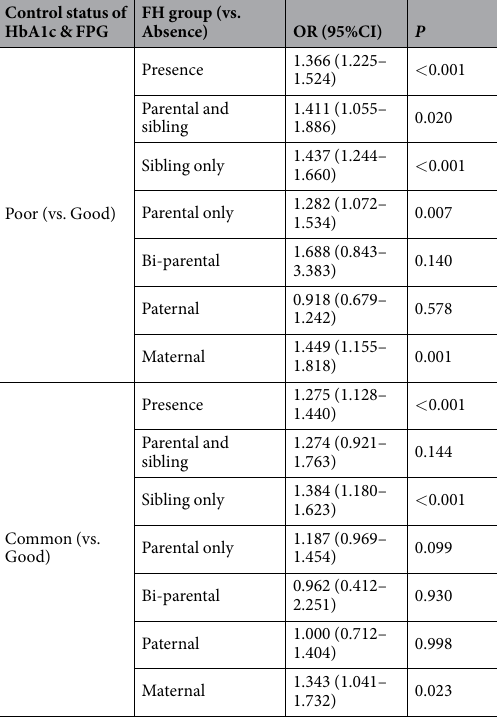
Table 3. Multiple logistic regression analysis of FH of diabetes and glycaemic control. Adjusted for age, gender, education, smoking, drinking, antidiabetic treatment, duration of diabetes, spouse with diabetes, BMI and physical activity. OR: odds ratio; CI: confidence